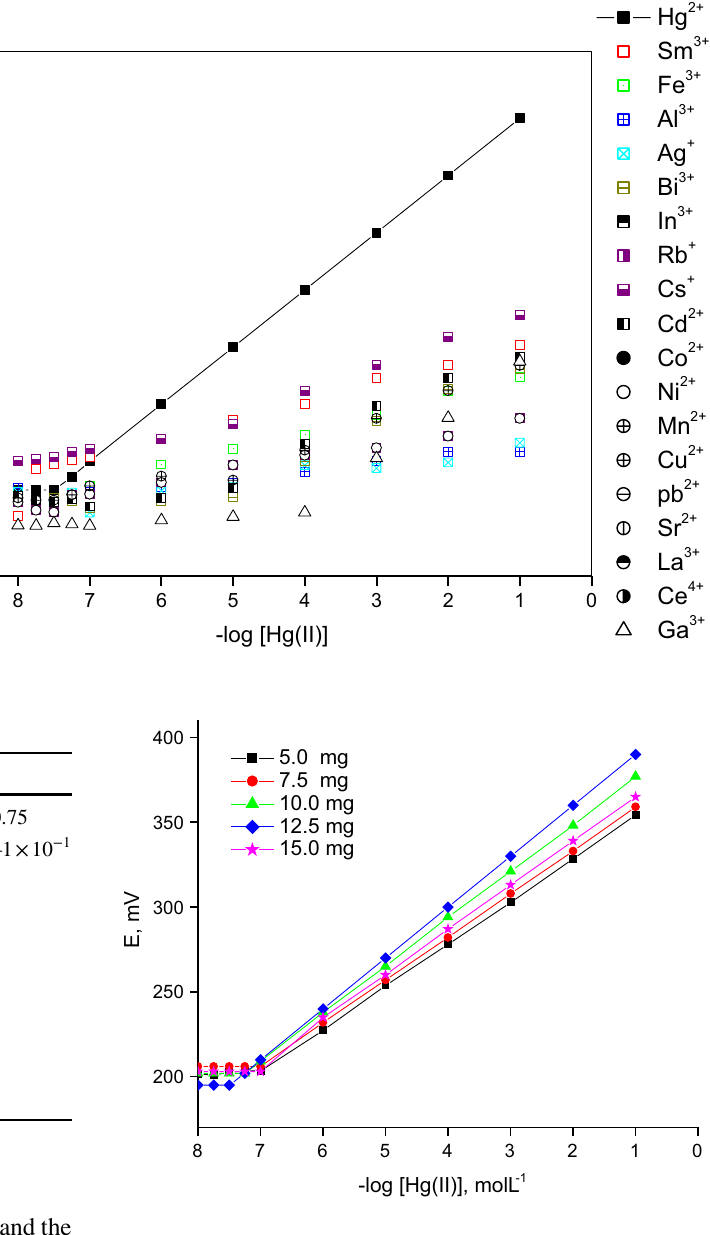
Fig. 2 Effect of ionophore content on calibration of the modified SPE